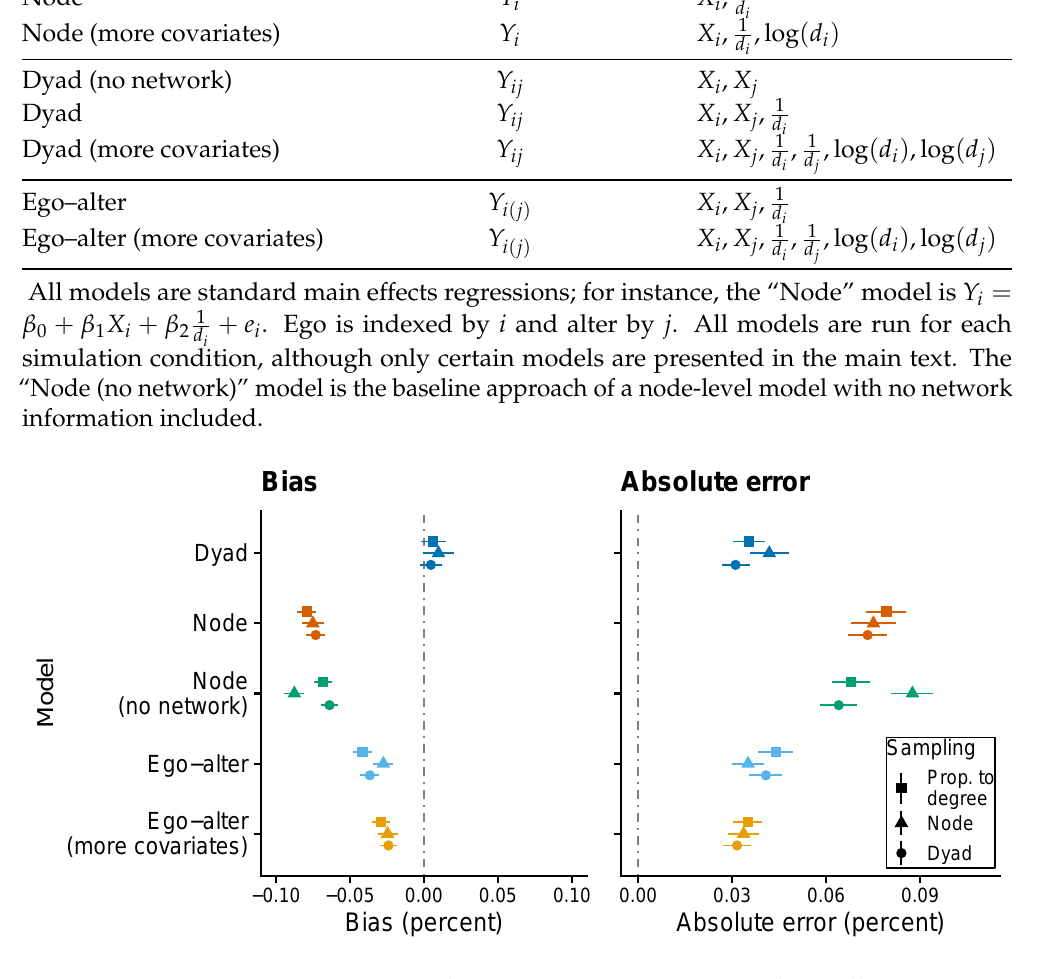
Figure 4: The bias and absolute error of homophily estimates using five different models, across sampling types. Node-level models without network variables display large